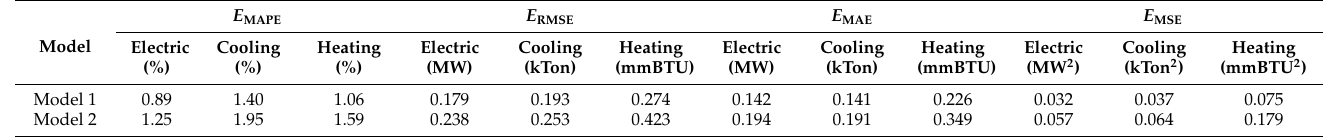
Figure 6. Comparison of results under different input feature sets. Table 2. Error comparison under different input feature